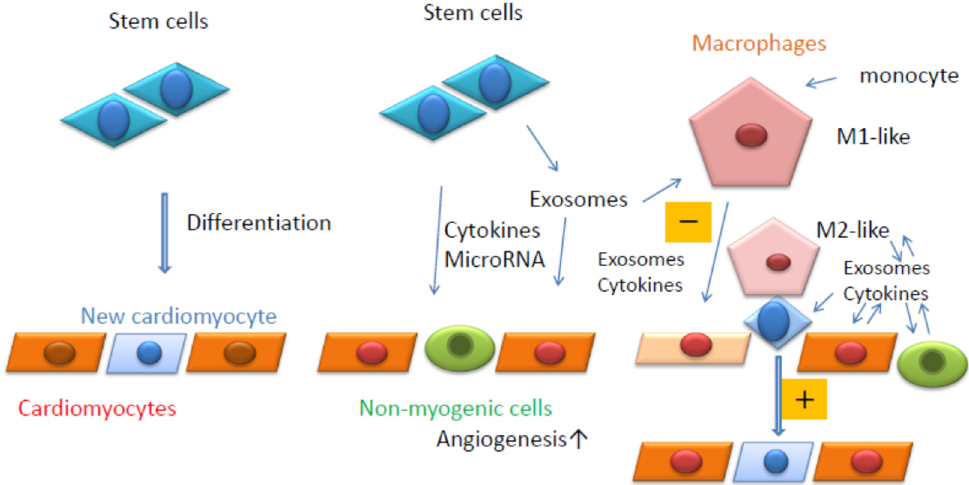
Figure 2. Summary of the current review. Stem cells can differentiate into cardiomyocytes ( Left ). Stem cells can release cytokines, microRNAs, and exosomes. Exosomes also contain cytokines and microRNAs ( Middle ). Resident macrophages can contact stem cells in close proximity to cardiomyocytes and induce their differentiation into cardiomyocytes ( Right ). Resident macrophages and monocyte-derived macrophages are affected by exosomes secreted by surrounding cells and can affect the surrounding cells positively (M2-like, +) or negatively (M1-like, − ) ( Right).